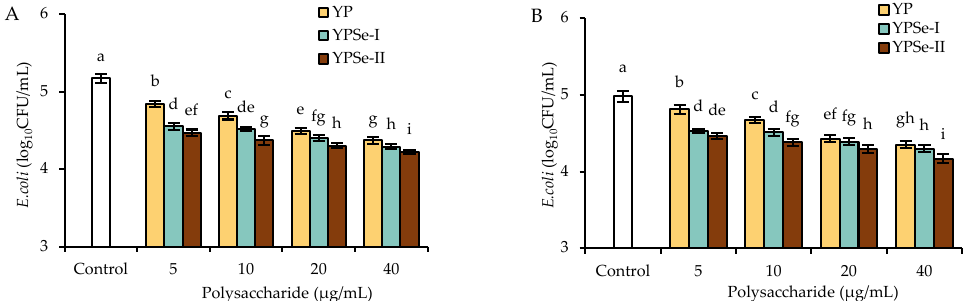
Figure 4. Anti-bacterial activity of the culture supernatants of IEC-6 cells exposed to YP, YPSe-I, and YPSe-II for 12 ( A ) or 24 h ( B ). Different lowercase letters above the columns denote a significant difference in the one-way ANOVA means ( p < 0.05).